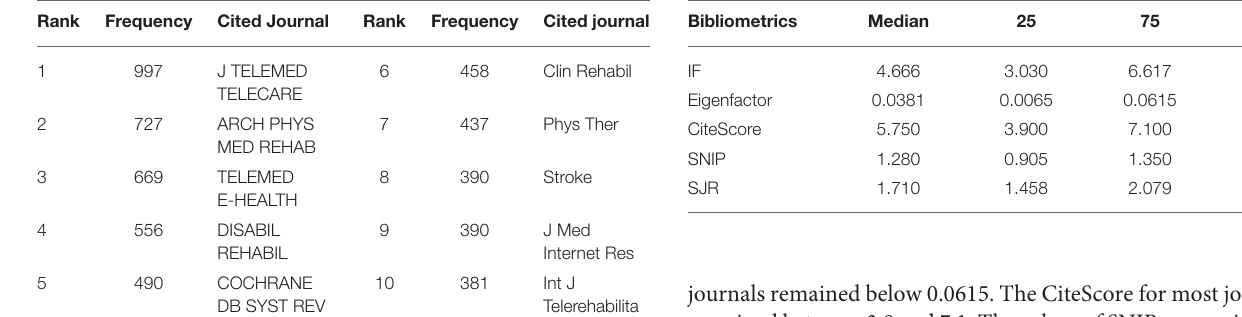
TABLE 2 | Top 10 cited journals related to telerehabilitation. TABLE 3 | Descriptive statistics of the bibliometrics from the top-10 cited